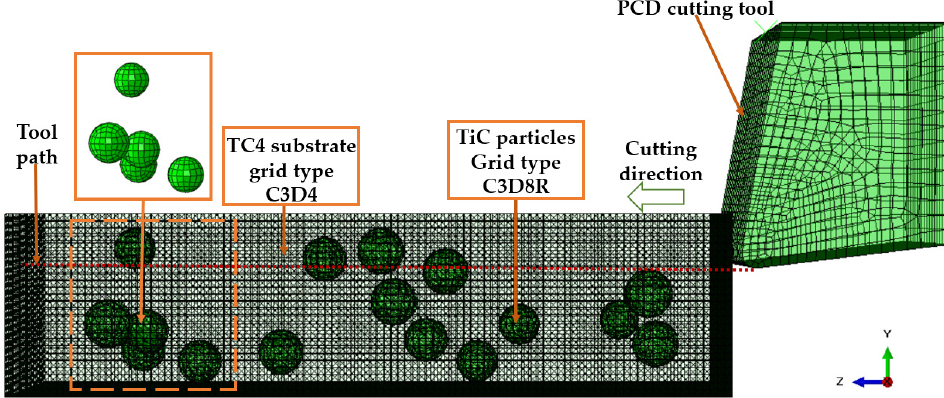
Figure 11. Simulation model of random distribution of enhanced particles in PTMCs.